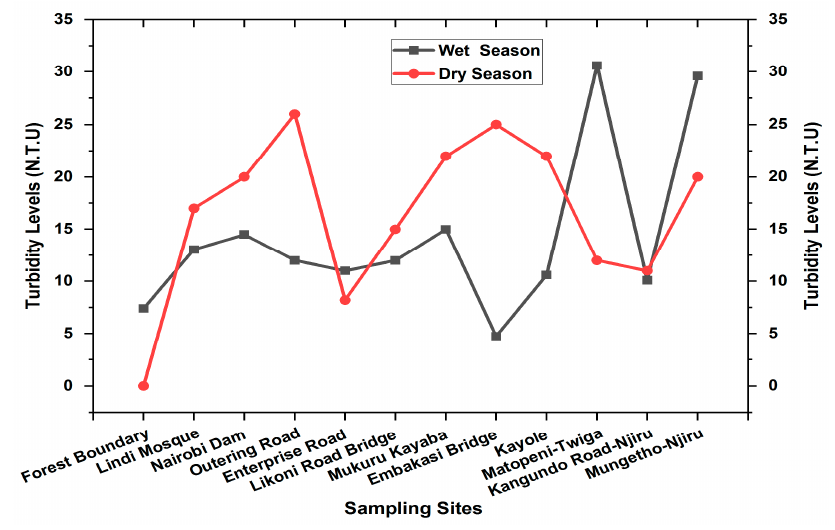
Figure 12. Turbidity levels for Ngong River measured between April and August 2021.